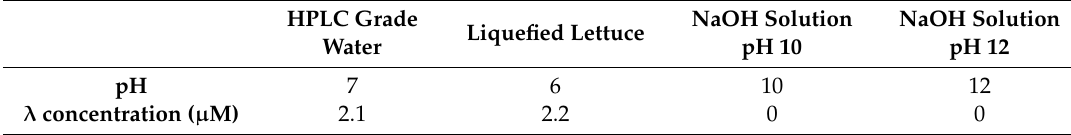
Table 4. Quantification of λ -cyhalothrin residues in alkaline